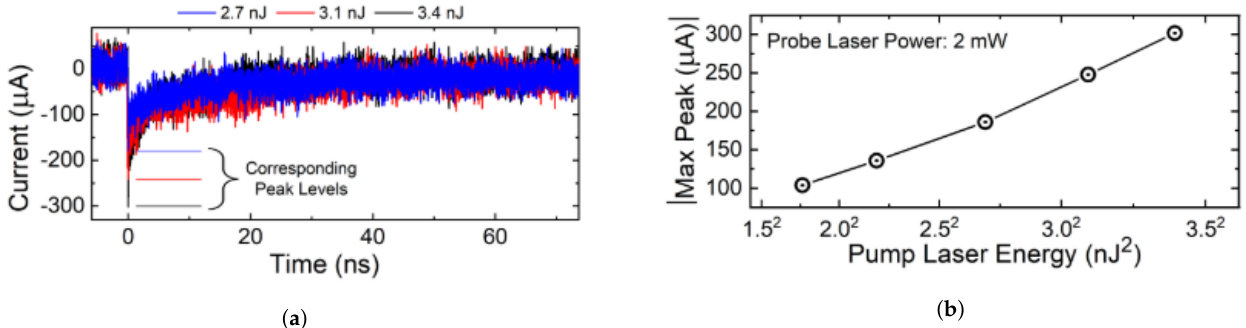
Figure 11. ( a ) Measured OSETs induced by 2.7, 3.1, and 3.4 nJ laser pulse. ( b ) Extracted OSET peak magnitudes across the laser pulse energy that was used to induce the transients (after